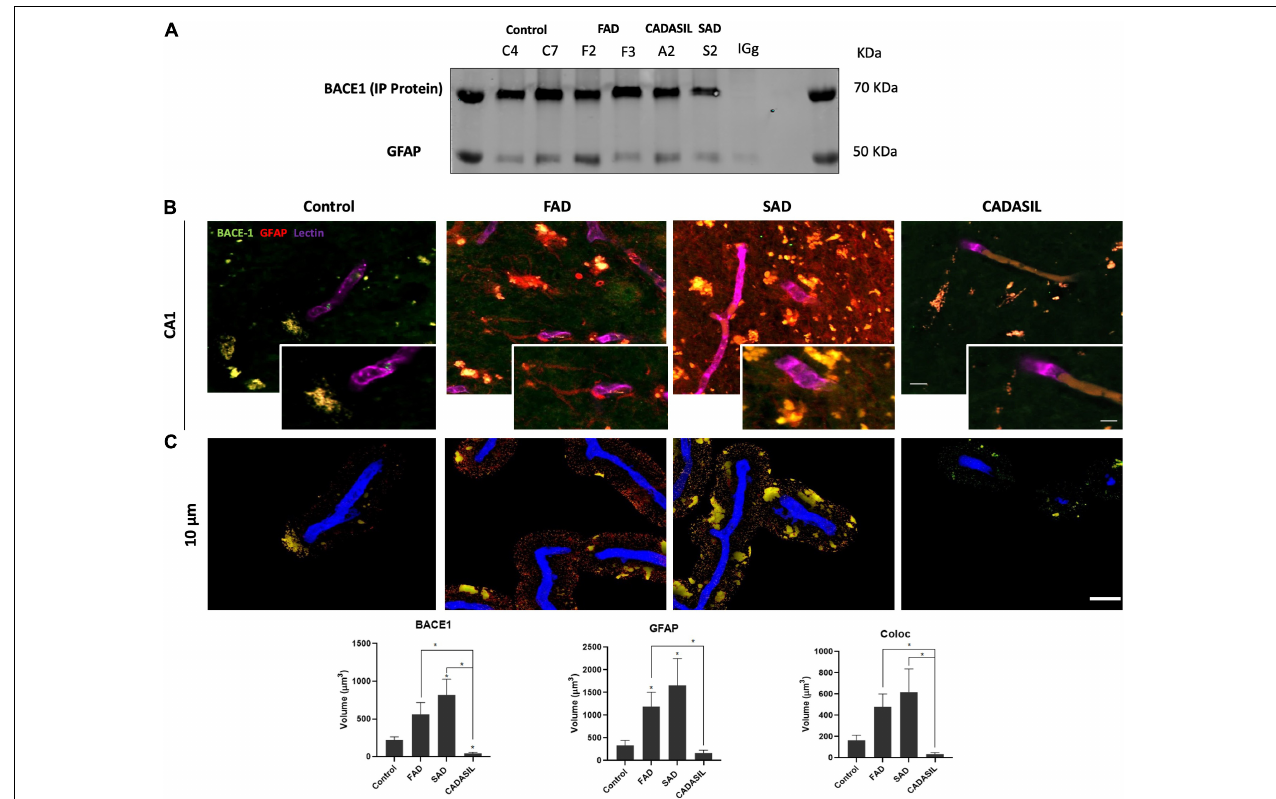
FIGURE 2 | BACE1 association with astrocytes and vessels in dementia brains. (A) Representative protein bands from the immunoprecipitation of BACE1 and co-inmunoprecipitation of GFAP are shown. IgG was used as a negative control for immunoprecipitation. (B) Z projection of Immunofluorescence of blood vessels triple-stained with DyLight 649- tagged UEA (color-coded in blue), anti-BACE1 antibody probed with Alexa Fluor 488 (green) and reactive astrocytes marked with Alexa Fluor 594 (red) in the hippocampal CA1 area. Magnification: 60x. Scale bar: 25 µ m. Insets: 5 µ m scale bar in B. (C) Z projection of the deconvolved images from the 3D reconstruction of the confocal images at 0 to 10 µ m away from the vessel surface. Scale bar: 25 µ m. The values represent the volumes in µ m 3 for the levels of BACE1 and GFAP and the colocalization of BACE1 and GFAP. The data are expressed as the means ± SEM. n = 4. * p <